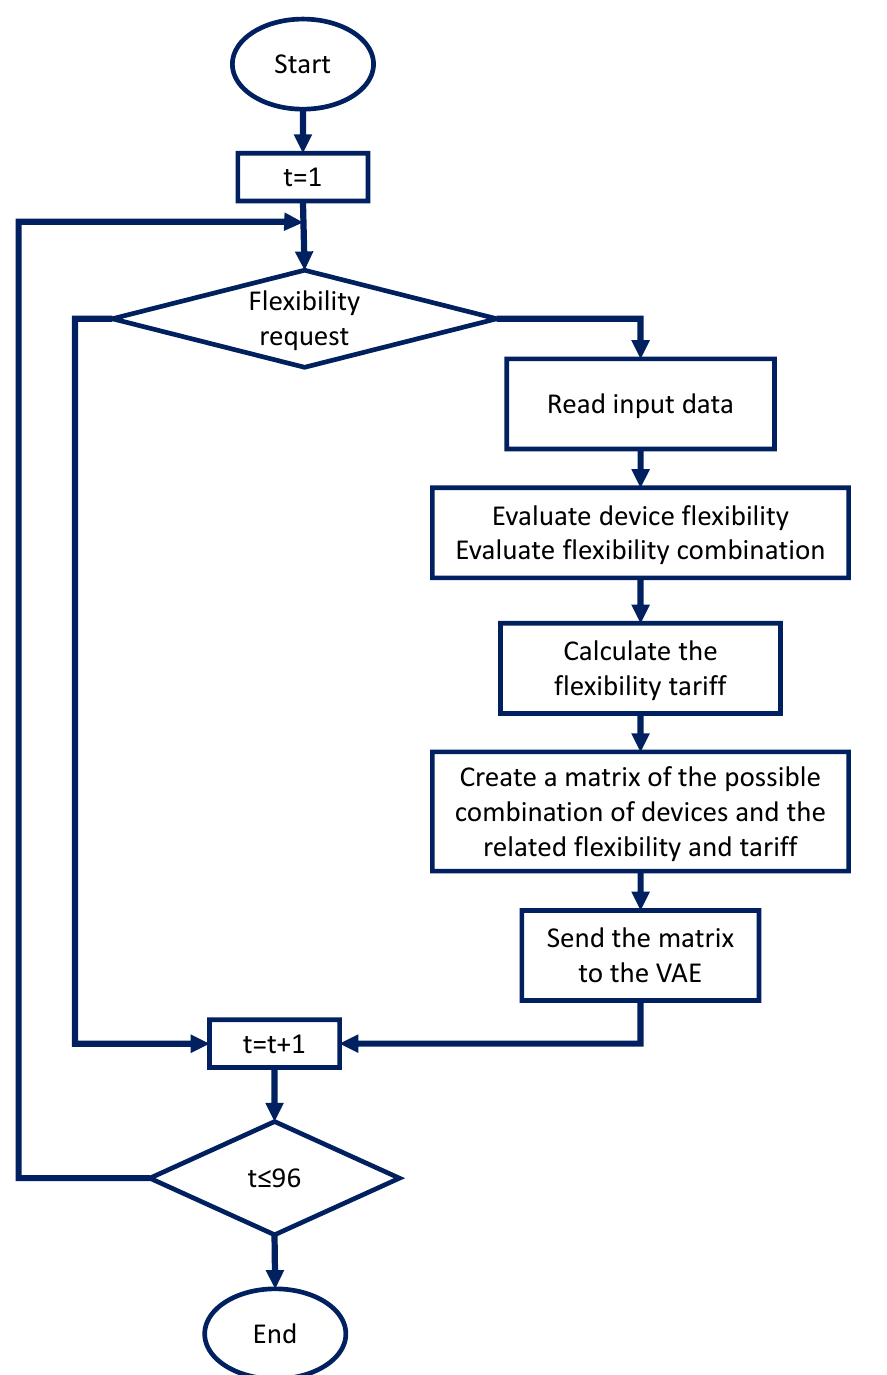
Figure 3. Day-ahead management procedure.